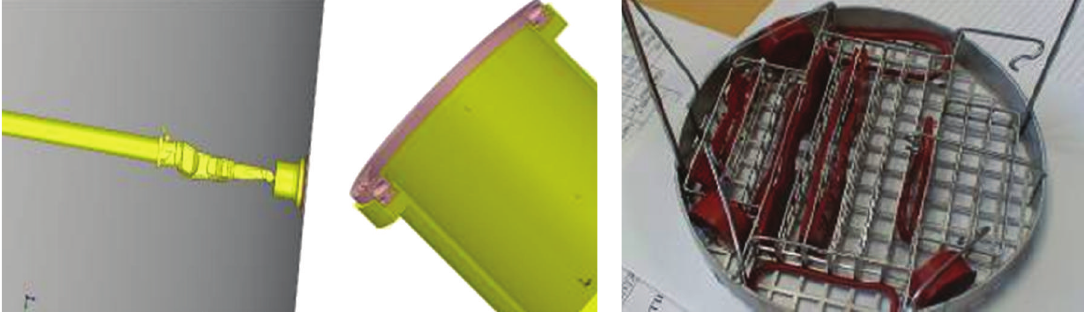
(a) insodium robot concept: articulated arm with a bell